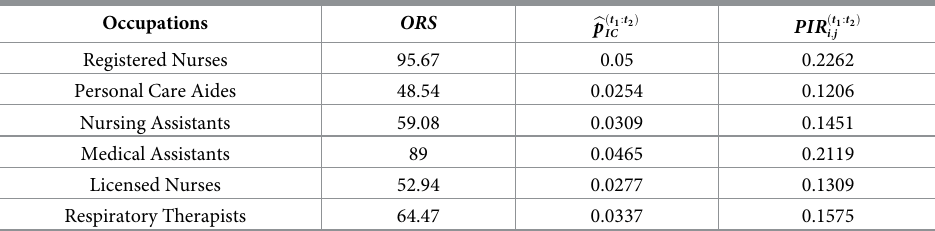
Table 3. Estimated individual-level infection risk for six different occupational